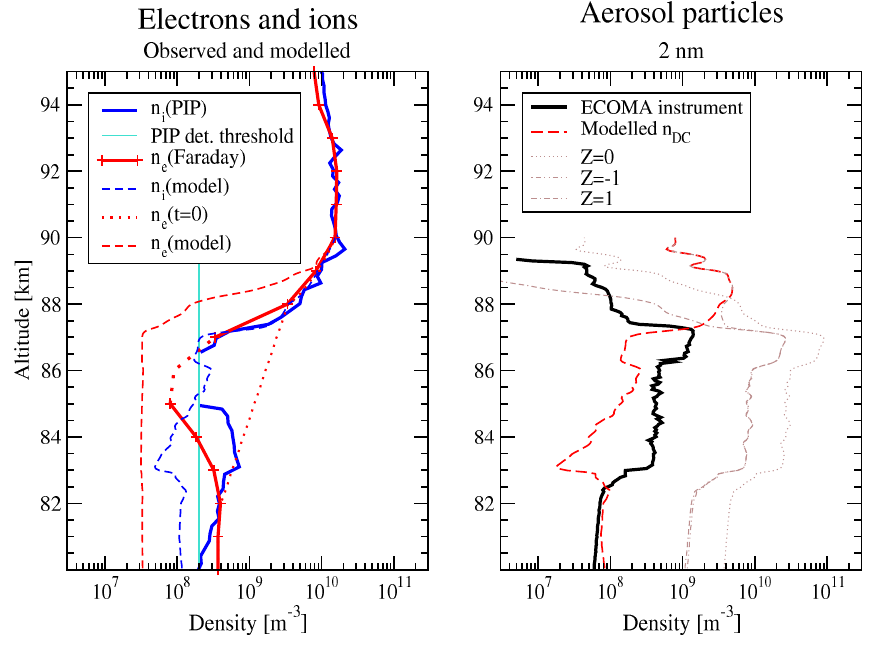
Fig. 4. Modelled and observed electron, ion, and aerosol particle densities. The model assumes α = α m = 6 × 10 − 13 m 3 s − 1 , n 0 as the initial electron and ion density (thin dotted line), r a = 2 nm, I a = 10 − 3 s − 1 , and an aerosol particle density which is 100 times the charge density measurement from the DC channel of the ECOMA instrument (assuming all particles have Z =− 1). n DC is the modelled aerosol particle charge density defined by